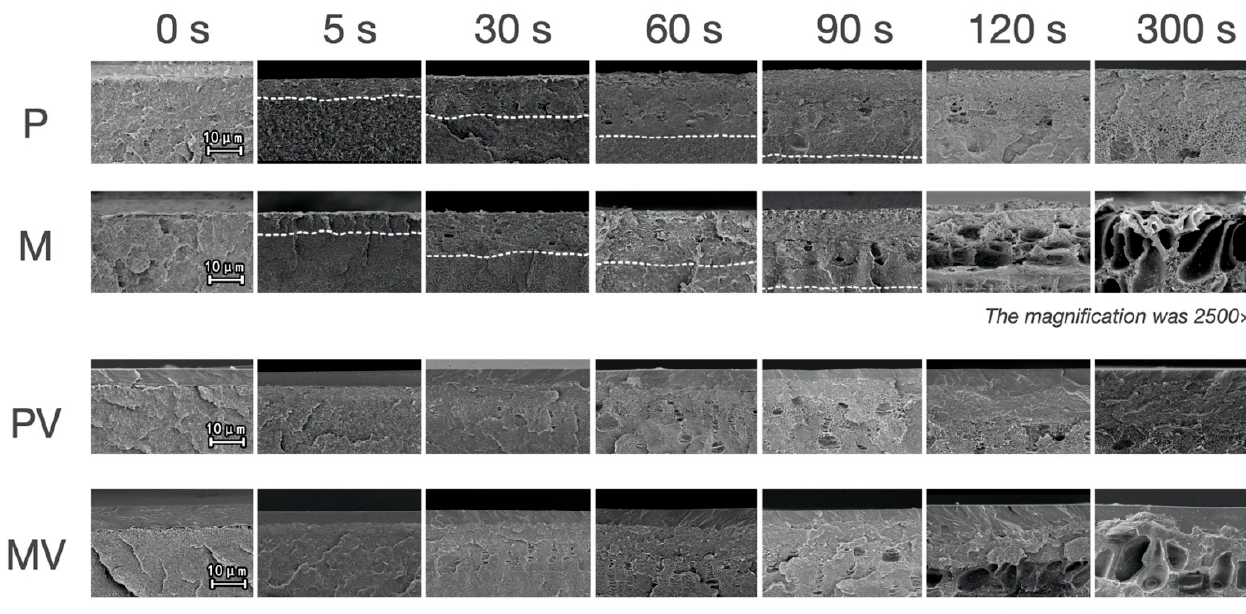
Figure 3. The SEM images showing the surface morphology of the etched PEEK at ×50 and ×5000 magnification. P : etched printed PEEK; M : etched milled PEEK.